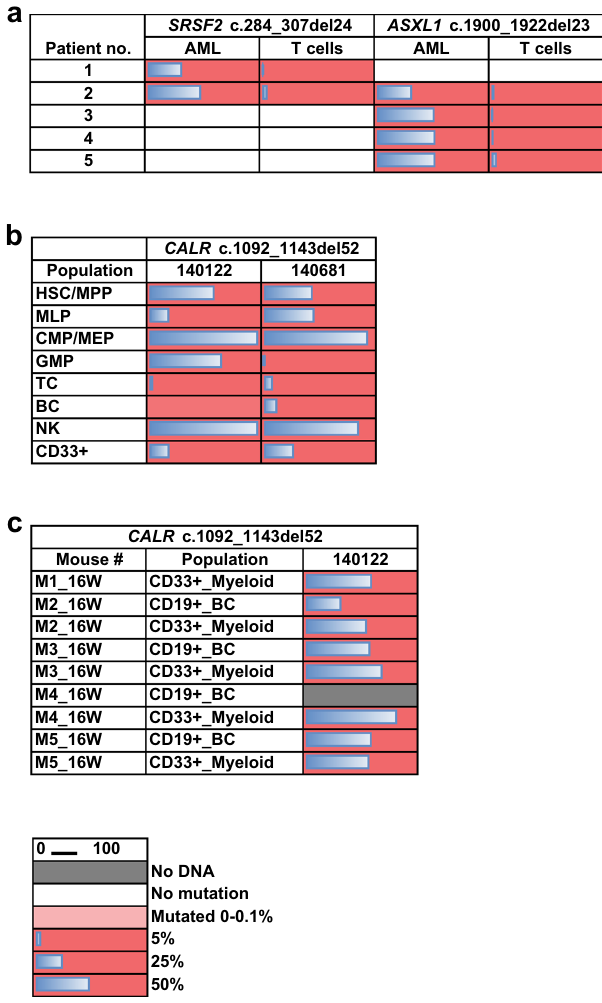
Fig. 3 Recurrent MH-based deletions originate in multipotent